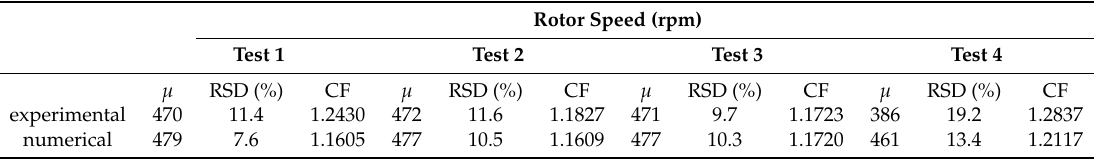
Table 5. Mean, RSD and CF of rotor speed time series from numerical and experimental analysis.